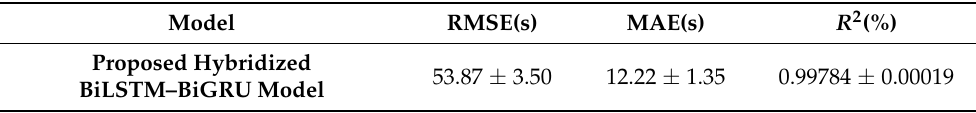
Table 4. The performance evaluation of our proposed heterogeneous ensemble approach using the overall data.